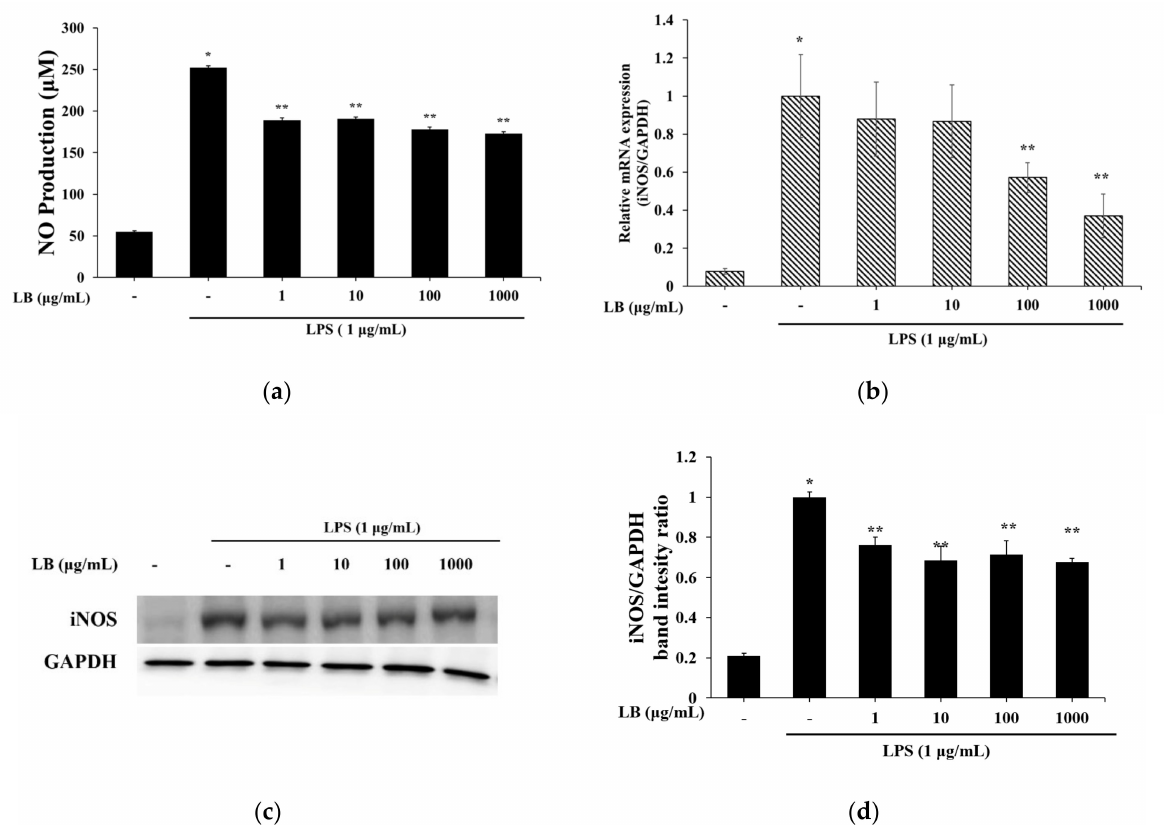
Figure 6. ( a ) NO level was measured by Griess assay. The LB treatment decreased NO production in LPS-stimulated peri- toneal mouse macrophages, regulated ( b ) mRNA expression of iNOS, and attenuated ( c ) protein expression of iNOS. ( d ) The bar graph of the relative intensity of the Western blotting band by Image J. Values are represented as the mean ± S.D. The data were analyzed by Bonferroni’s post-hoc test. * p < 0.05 versus normal group and ** p < 0.05 versus LPS stimulation-only